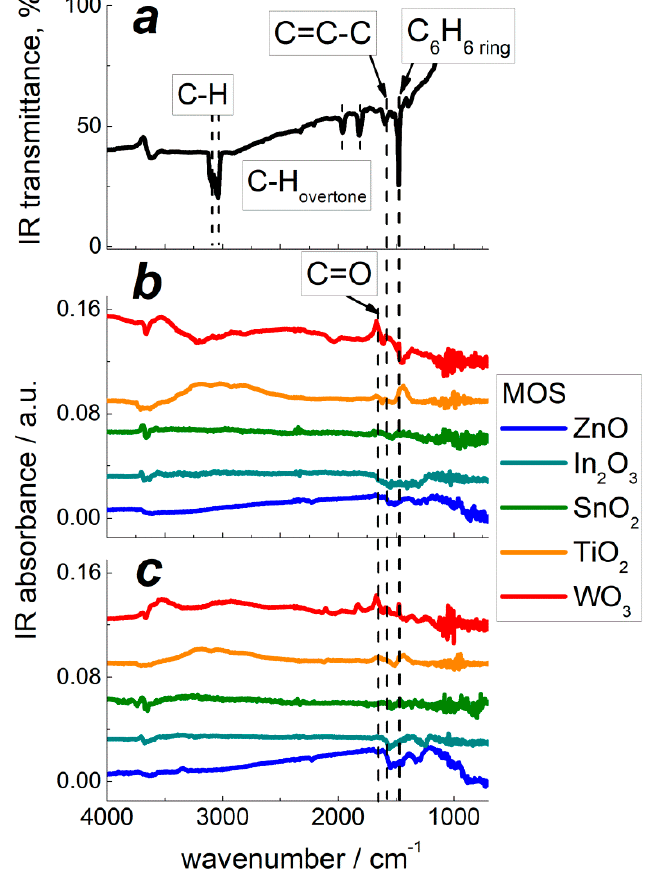
Figure 9. FTIR spectrum of SnO 2 impregnated with liquid C 6 H 6 ( a ); DRIFT spectra of pristine MOS ( b ), and PtO x − modified MOS ( c ) exposed to 10 ppm C 6 H 6 for 1 h at room temperature. DRIFT study of benzene conversion on pristine MOS at temperature 220 °C showed